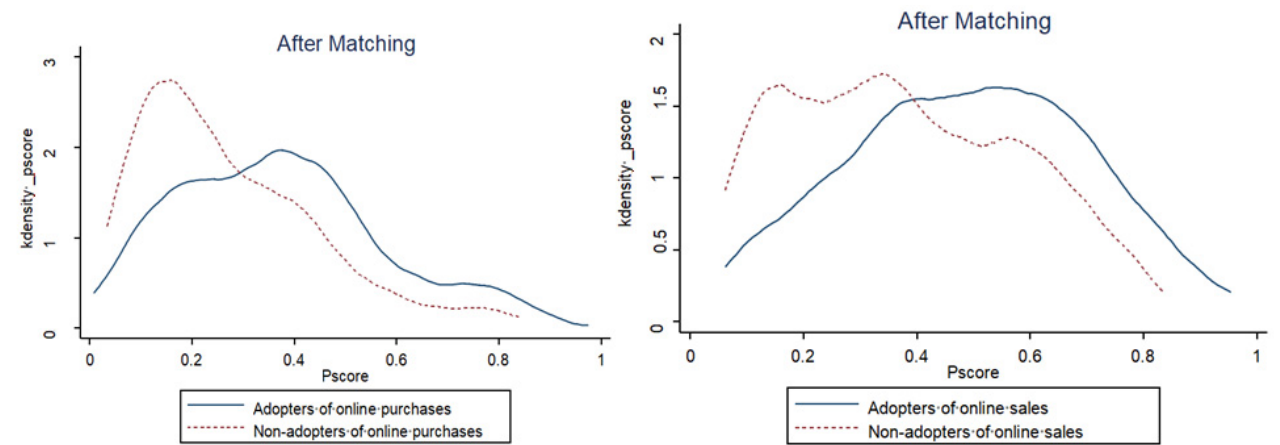
Figure A1. Propensity score density function of adopters and non-adopters of online purchases and sales.